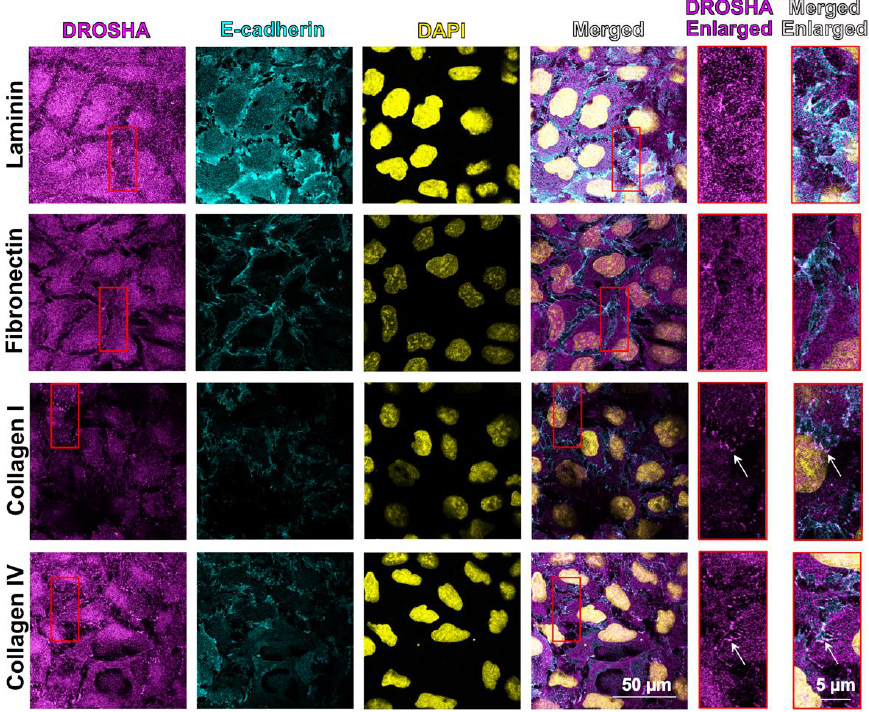
Figure 5. Representative images of basal areas of Caco2 colon epithelial cells plated on laminin, fibronectin, collagen I, and collagen IV stained by immunofluorescence for DROSHA (magenta) and E-cadherin (cyan). Nuclei were stained using DAPI (yellow). Arrows indicate basal areas of cell–cell contact. Selected insets indicated in red boxes are shown enlarged on the right.